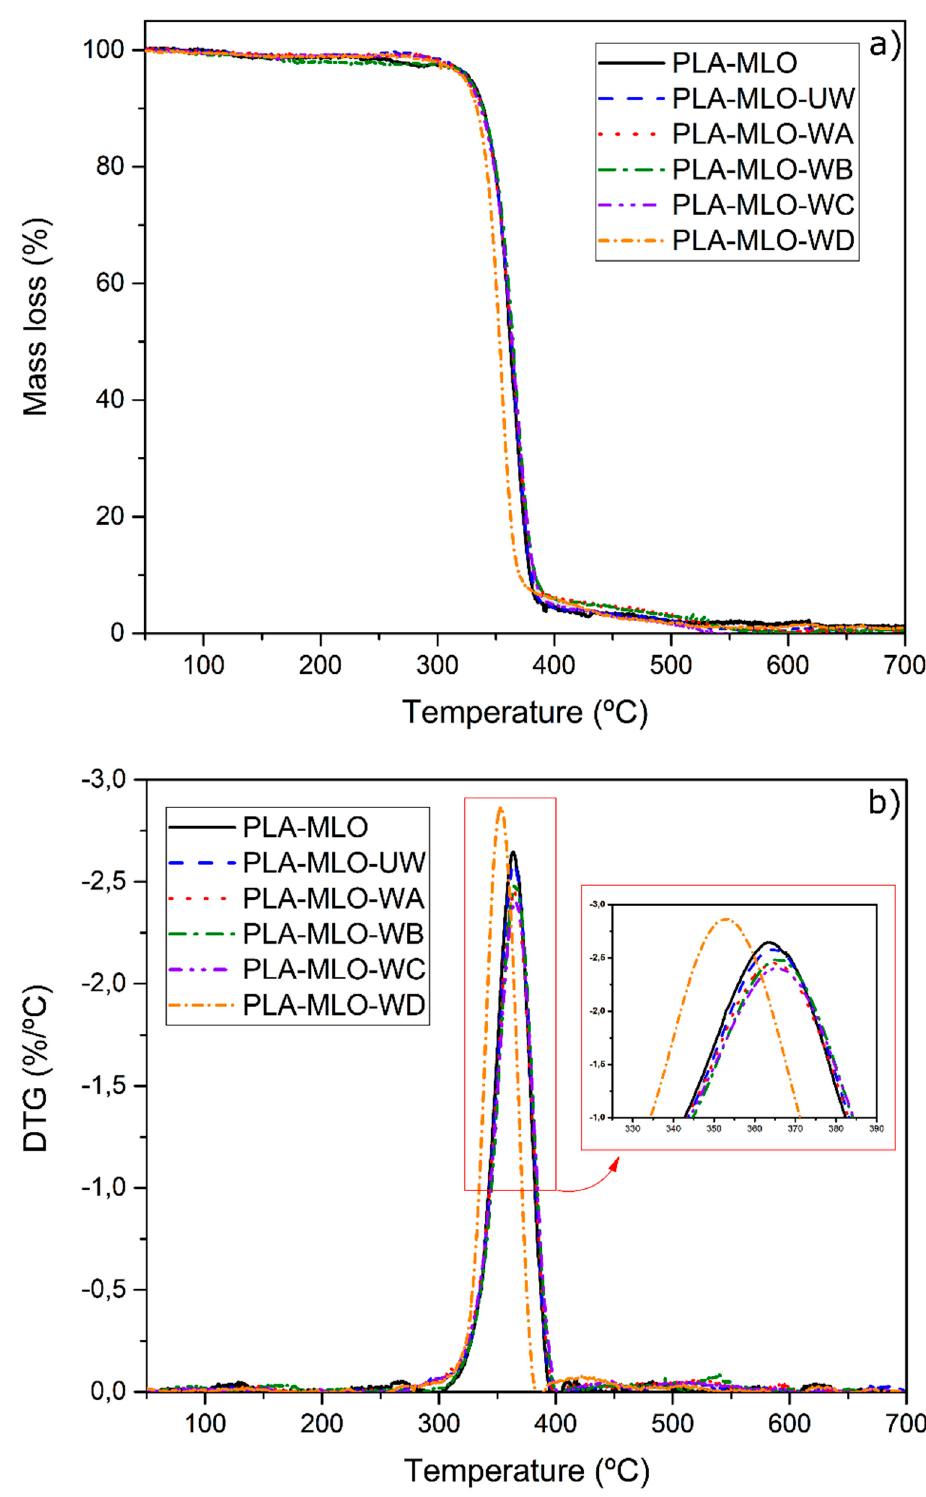
Figure 6. ( a ) Thermogravimetric analysis (TGA) and ( b ) first derivative of the TGA curve (DTG) of Figure 6. a) Thermogravimetric analysis (TGA) and b) first derivative of the TGA curve (DTG) of PLA–wool PLA–wool FRP.